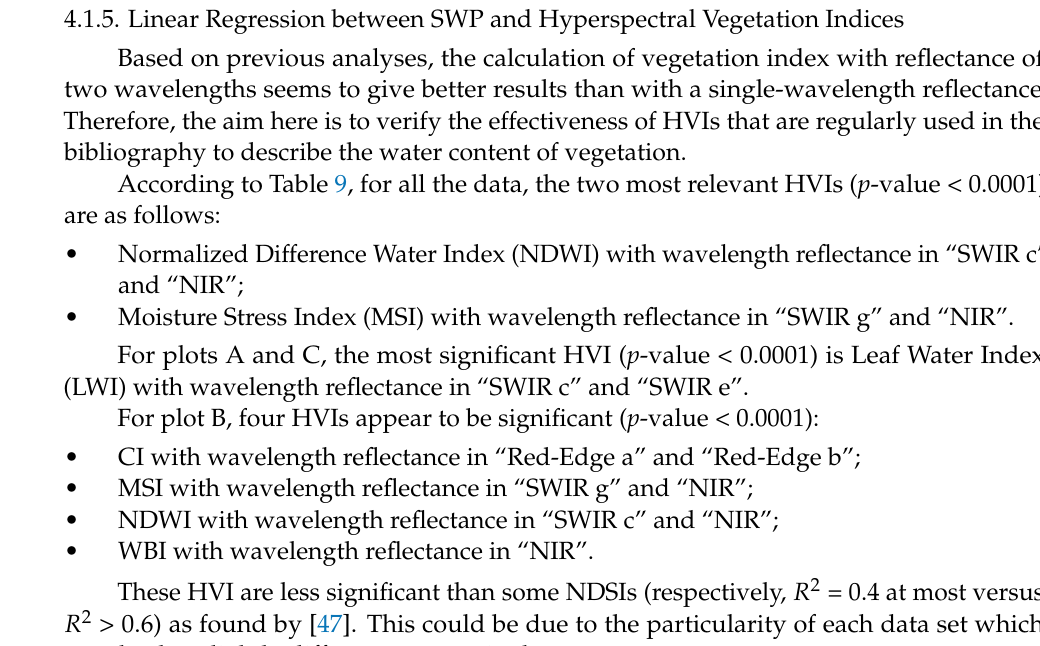
Table 9. Coefficient of determination between HVI and SWP (values in bold are different from 0 at significance level alpha = 0.05). All Data Plots A and C Plot B Variables SWP SWP